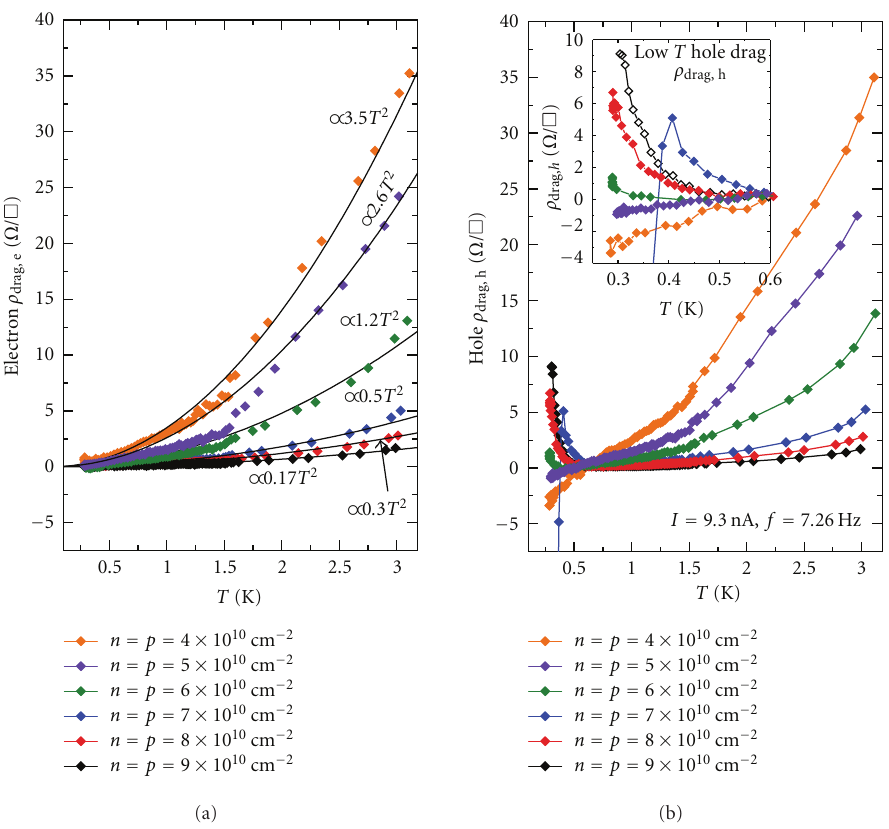
Figure 10: Drag resistivity measured on electron (a) and hole layer (b) versus temperature for n = p = 4,5,6,7,8,9 × 10 10 cm − 2 , down to 300 mK. (Inset) Expanded low-temperature drag resistivity measured on hole layer. For the lowest density, k F d ≈ 1 . 25, r s ,e = 2 . 8, and r s ,h ≈ 14 . 1. (Device: B138/C4-2-10nm Barrier).